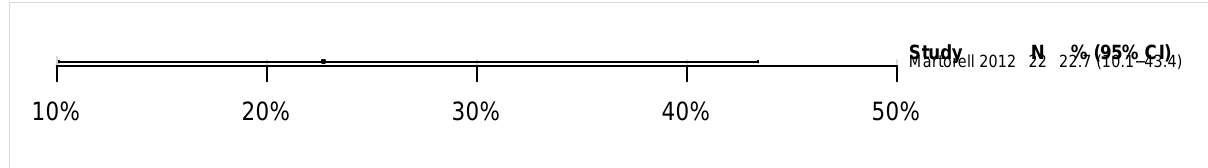
Figure 57: HPV 16 prevalence among women with low-grade cervical lesions in Peru, by study